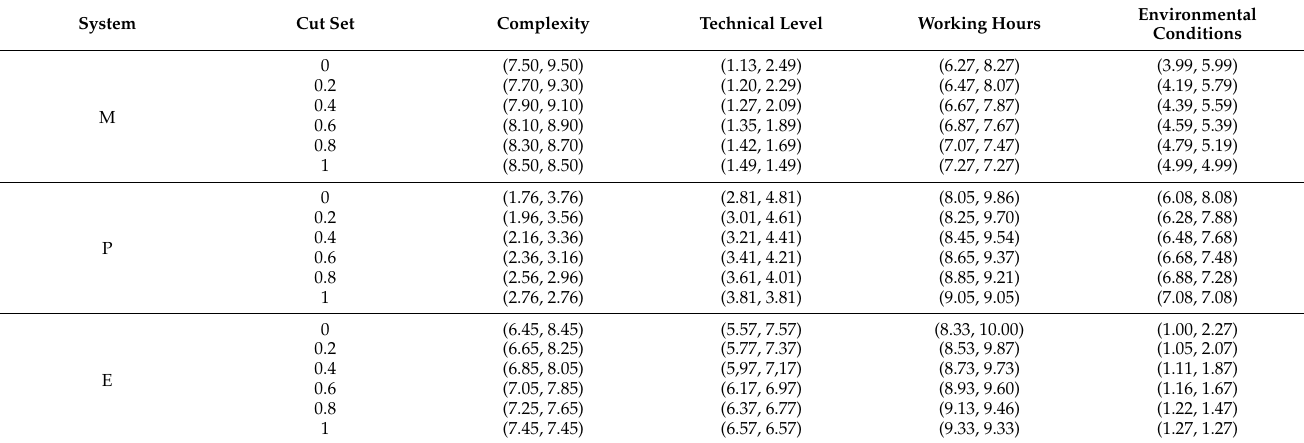
Table 6. λ cut set of each system evaluation factor.